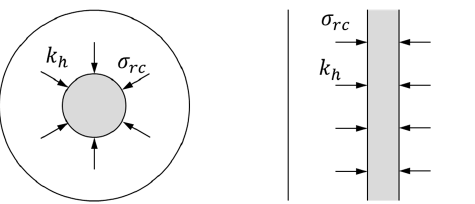
Figure 7. Different confinement and seepage conditions for columns in axial symmetry and for longitudinal gravel trenches in plane strain.